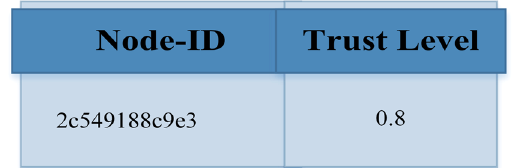
Figure 3. Trust-table for each WSN node. Table 2. Notations and their description.